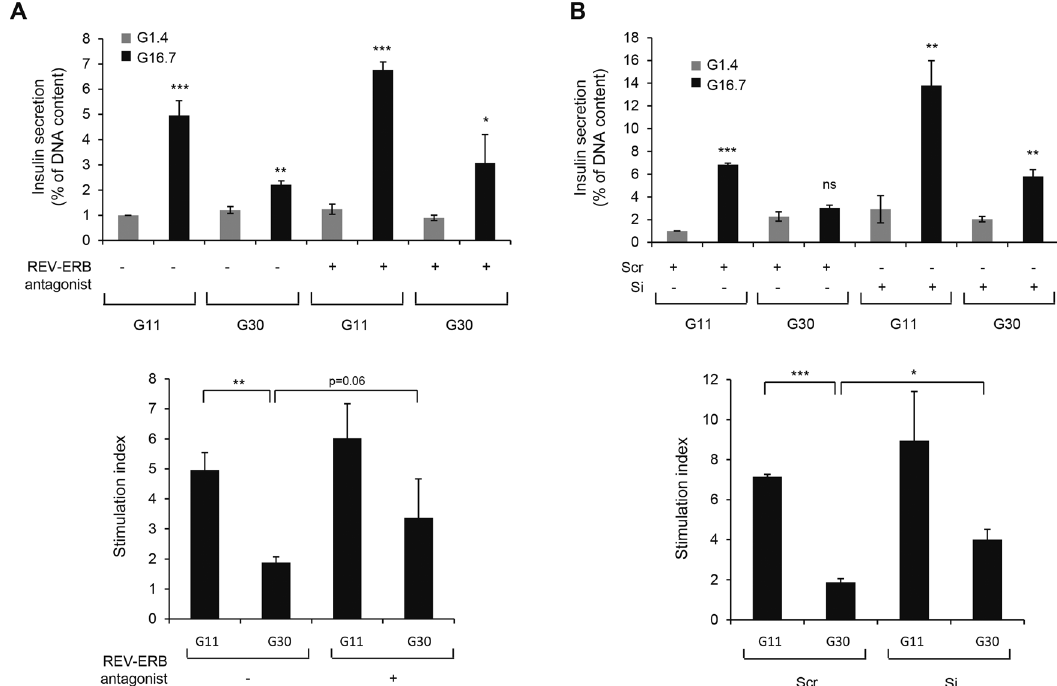
Fig. 8 Negative modulation of REV-ERB α partially protects from glucotoxicity-induced β -cell dysfunction. A INS-1E cells were exposed to glucotoxicity [30 mM glucose (G30) vs. control 11 mM glucose (G11)] for 48 h in the presence or absence of REV-ERB antagonist (SR8279, 10 μ M). Following a 2 h quiescent period in Krebs 1.4 mM glucose (G1.4), cells were stimulated with 16.7 mM glucose (G16.7) for 1 h at 37 °C; (G1.4 refers to non-stimulated cells). The graph represents insulin secretion normalized to DNA concentration ( n = 4